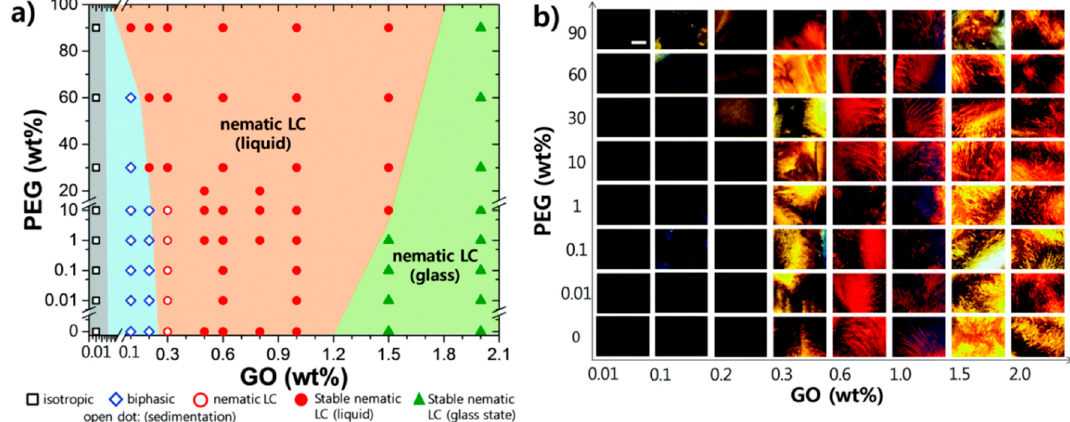
Figure 12. ( a ) The phase diagram of a graphene oxide liquid crystal with added polyethylene glycol (PEG) as determined by Shim et al. [53]. ( b ) Typical POM images for different GO/waterPEG mixtures. Weak birefringence can be seen as the PEG concentration is increased in an initially isotropic GO dispersion. Republished with permission of the Royal Society of Chemistry, from Shim et al. [53]; permission conveyed through Copyright Clearance Center, Inc.